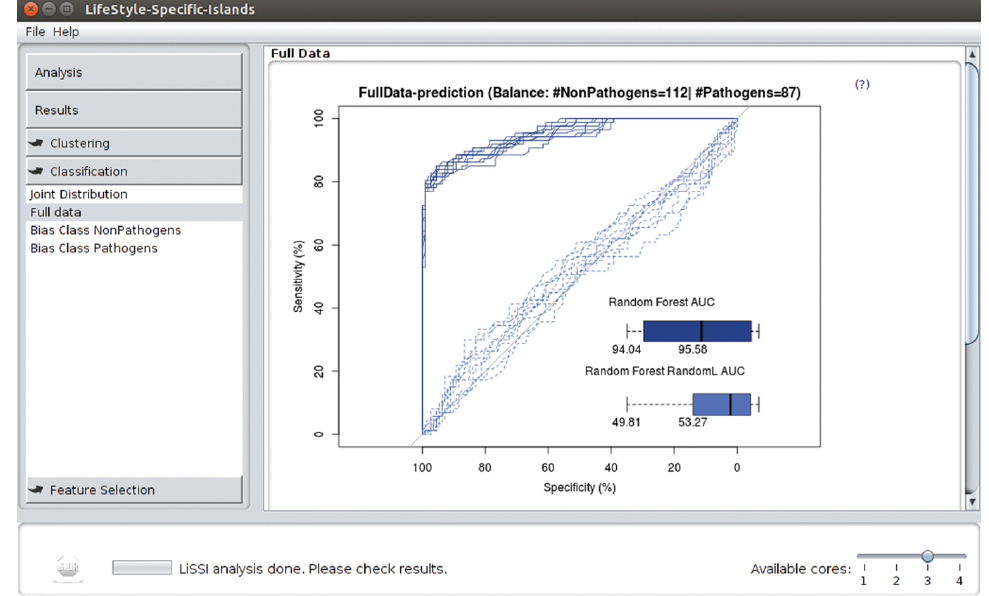
Figure 3: LiSSI: Pathogenicity classification performance results. A Receiver Operating Characteristics (ROC) plots shows the performance of the classification models using genes as features to distinguish pathogenic actinobacteria from non- pathogenic ones. The data was evaluated five times using different 5-fold cross-validation sets to assess the robustness of the classifiers. The real label classifier curves are presented as dark-blue solid lines, while the random label classifiers are depicted as light-blue dashed lines (the ones close to the baseline). The variation of the AUCs (area under curve) in the cross-validation was included in the figure as a box-plot (bottom right). The numbers below each box-plot are the lower and upper